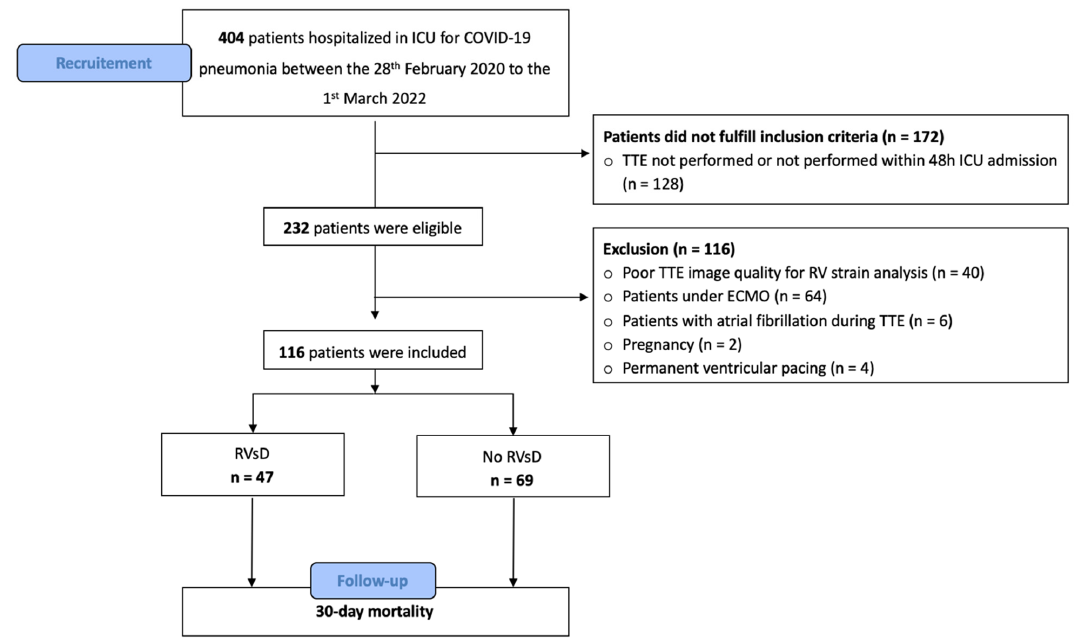
Figure 2. Flow chart of the study.